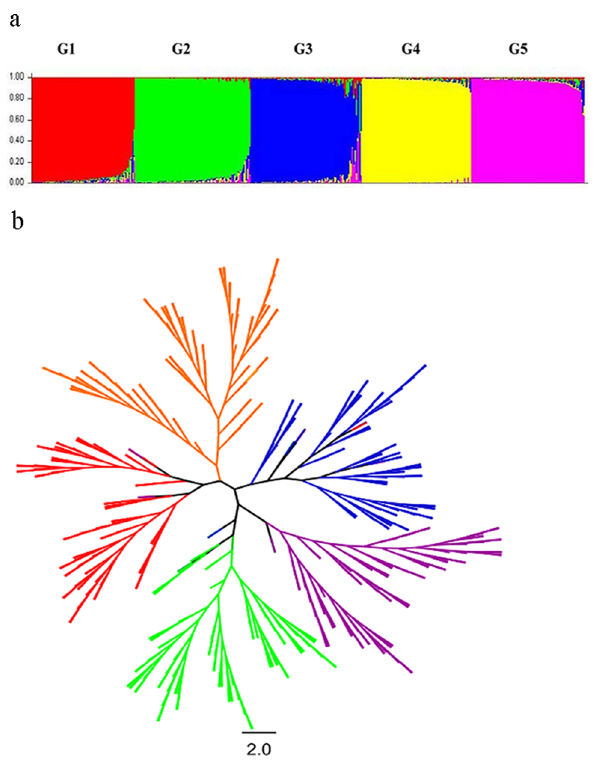
Figure 1. Molecular classification of Chinese M . sinensis germplasm. a Population structure of Chinese M . sinensis germplasm. b Classification of Chinese M . sinensis germplasm based on neighbor- joining tree clustering analysis. Note: The colors of the branch is consistent with the colors of structure group in a (G1= red , G2= green , G3= blue , G4= yellow , and G5= purple ). The vertical bars represent each genotype while division of the bars shows the genome content based on the sub-population